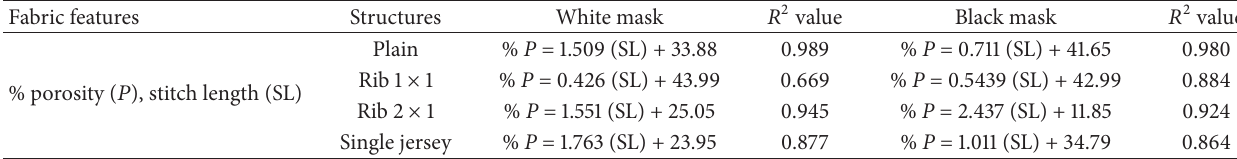
Table 6: Linear regression equations: % porosity against stitch length (FKM samples).